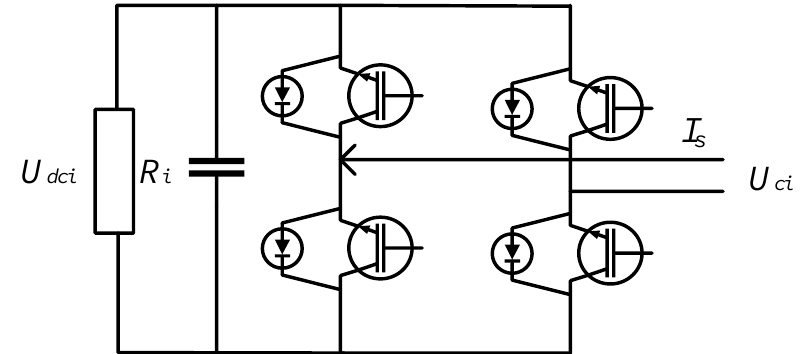
Figure 4. Steady-state H-bridge module.